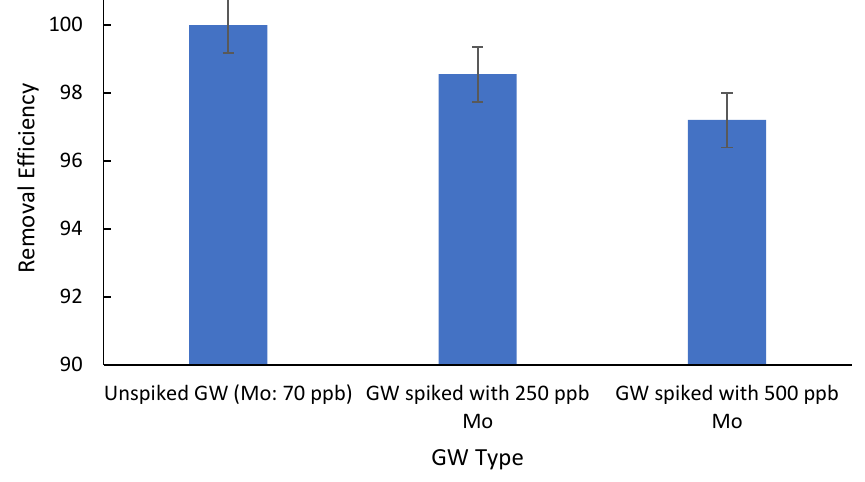
Figure 20. Removal of Mo with CDC from different GW types; CDC loading: 0.6 g/L; pH: 3; agitation speed: 150 RPM.